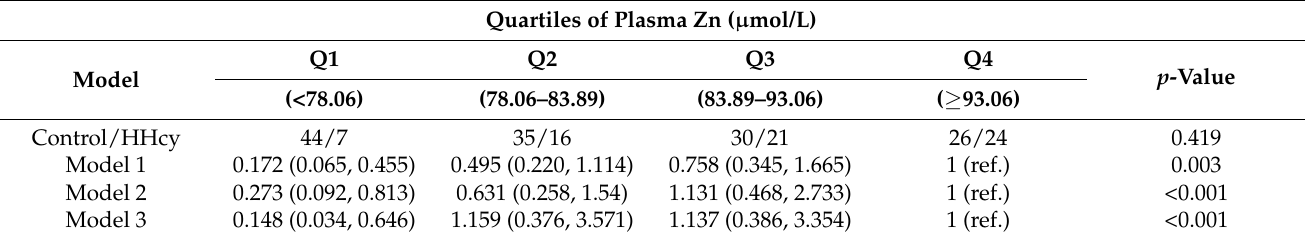
Table 4. Associations between Zn and the HHcy odds ratio.